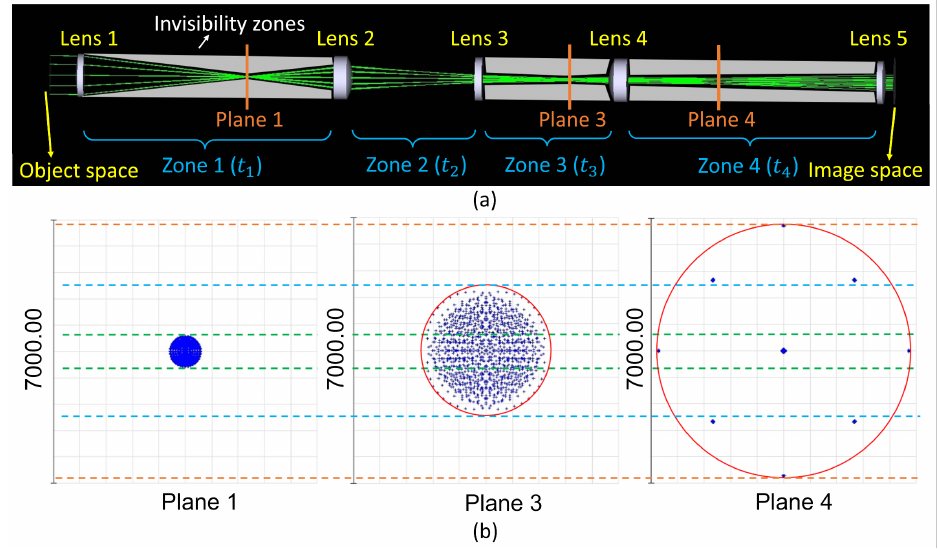
Figure 2. Simulation results of Case f 3 = − 150 mm. ( a ) Ray tracing for the case f 3 = − 150 mm. We can see the zones of invisibility and the planes used to calculate the diameter of the beam at the points of maximum invisibility. ( b ) Spot Diagram for the three planes of interest using the same scale to compare the